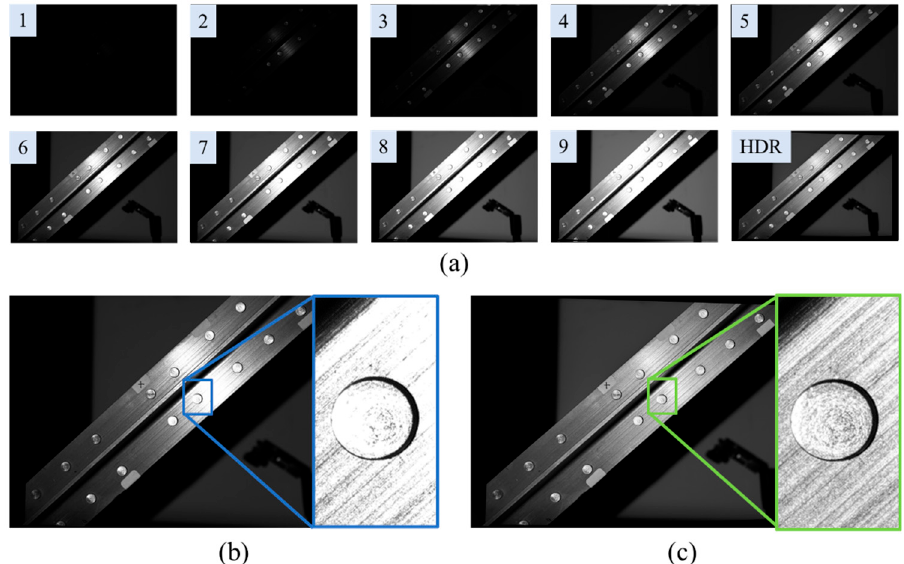
Figure 5. HDR texture fusion. ( a ) demonstrates the texture images of different projected intensities and exposure times. ( b ) is the texture image under 80 projected intensity and 33.333 ms exposure time. ( c ) is the HDR merged texture under the parameter settings in Table 1.